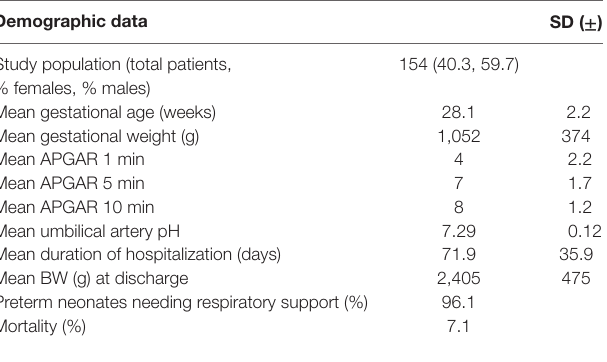
TaBle 1 | Demographic data of the study population. Demographic